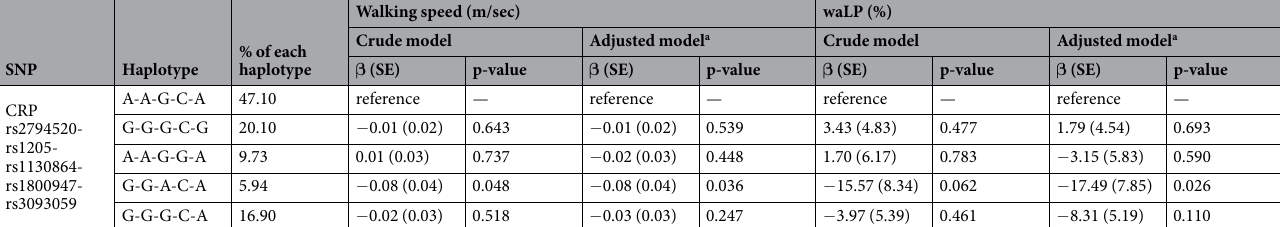
Table 4. The effect of CRP haplotypes on walking speed and waLP in women. β = estimated coefficient of regression model; SE = standard error. a: Adjustment of age, BMI, physical activity, smoking, drinking, and number of disease